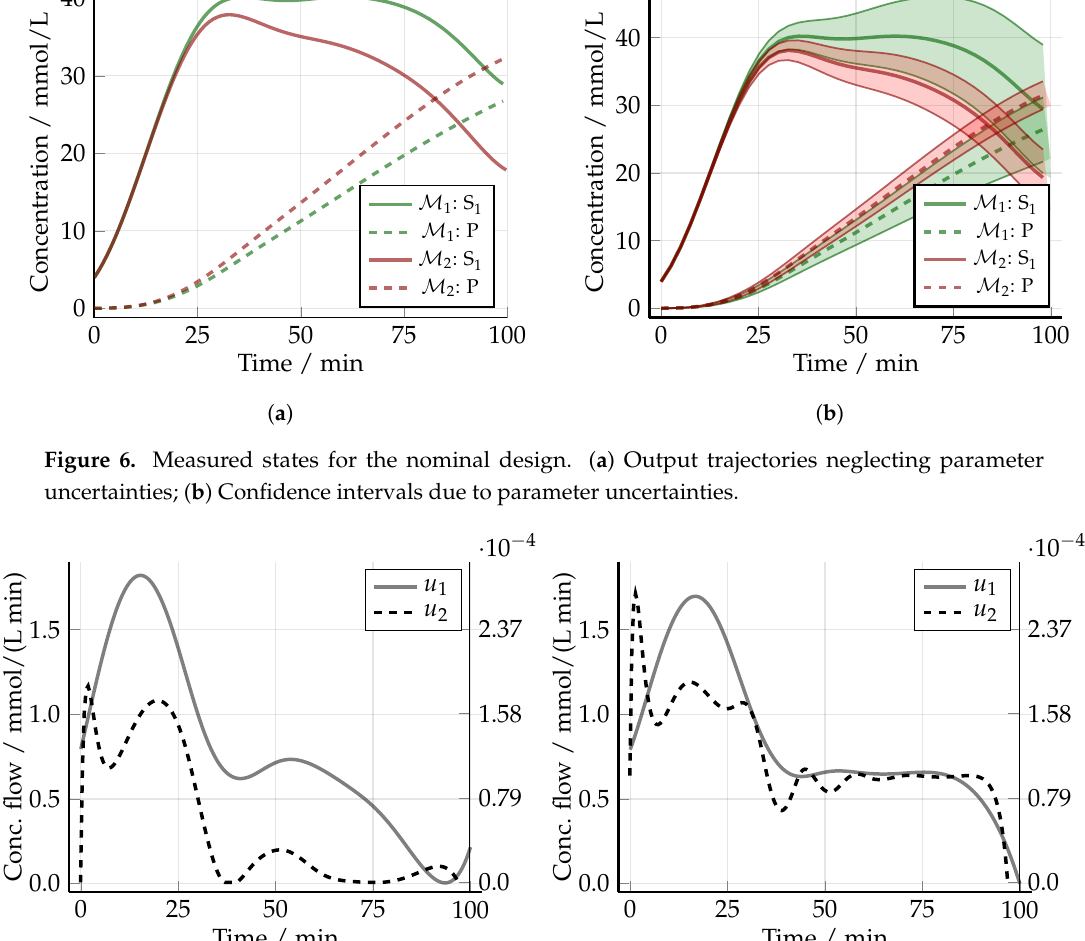
Figure 6. Measured states for the nominal design. ( a ) Output trajectories neglecting parameter uncertainties; ( b ) Confidence intervals due to parameter uncertainties.